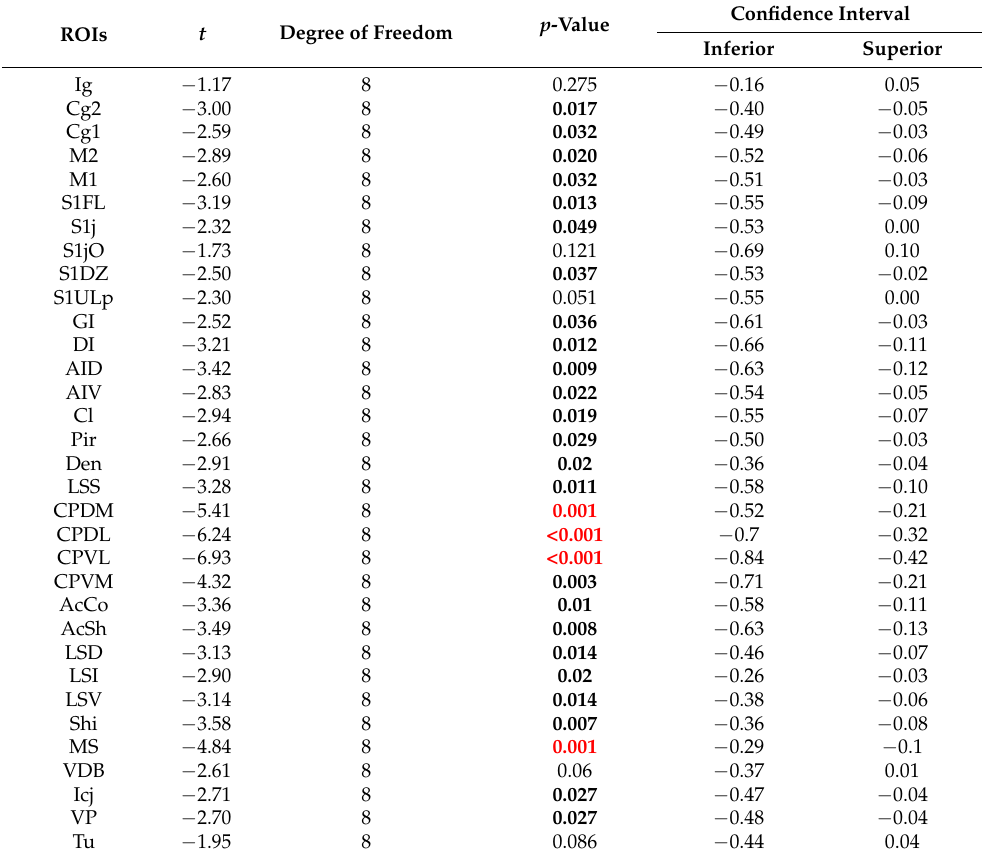
Table 4. Results of Student’s t test comparing the KET/VEH vs. KET/ASE groups throughout the 33 regions of interest. Significant values were outlined in bold. Significant adjusted p -values after the Bonferroni correction were given in red. ROIs: regions of